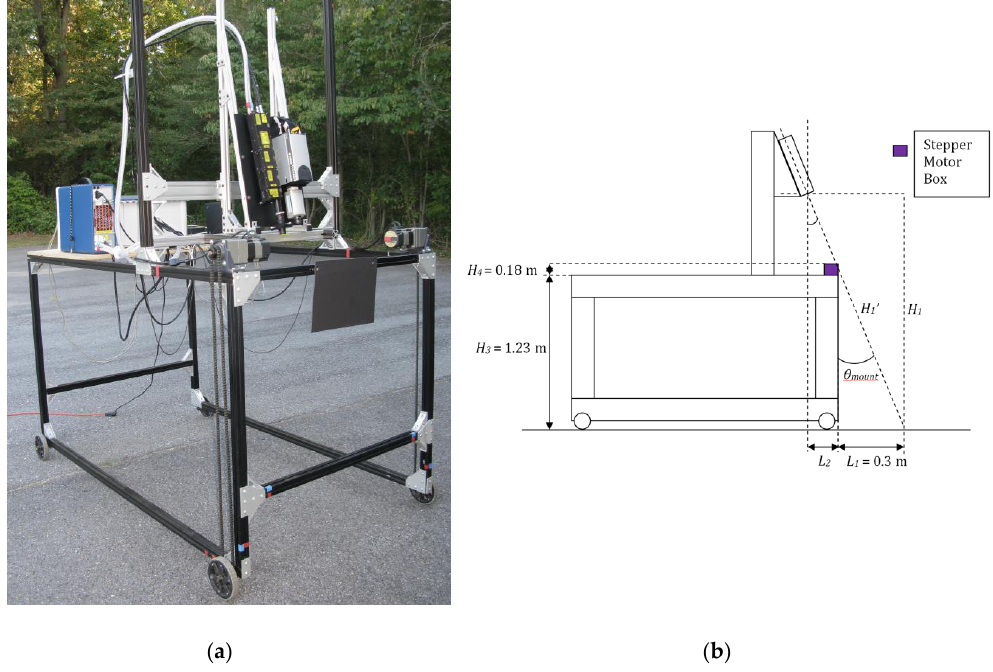
Figure 1. Photo of the cart ( a ); along with a schematic showing the dimensions and variables used for illumination and imaging field calculations ( b ).